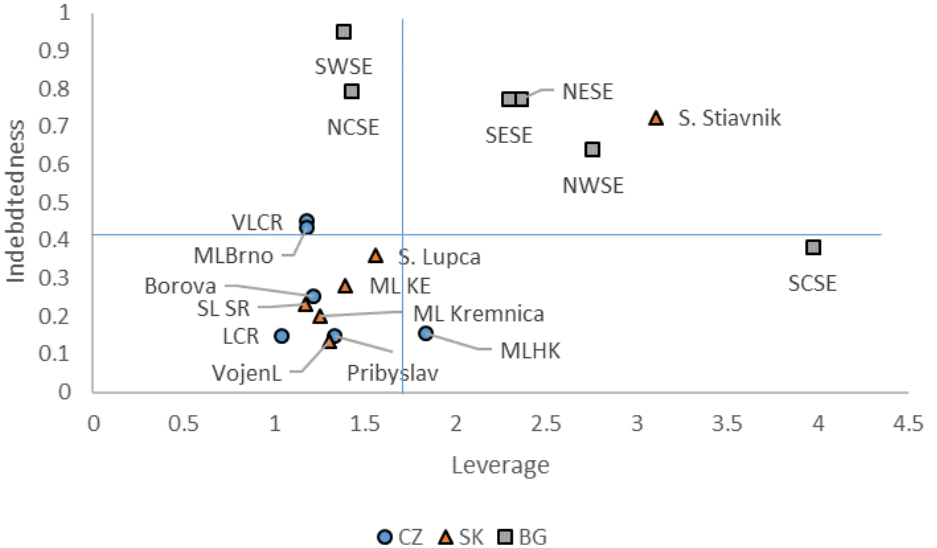
Figure 2. Grouping the enterprises according to average leverage and indebtedness (from the present authors).